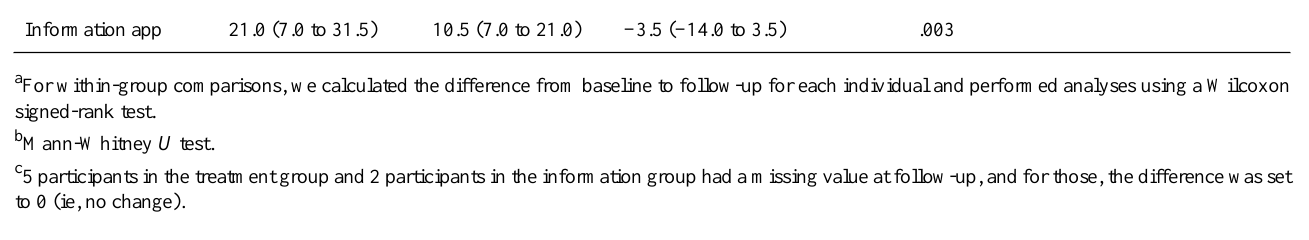
P valueParticipants, n (%)Allocation and incontinence aid usage Within-group comparison a